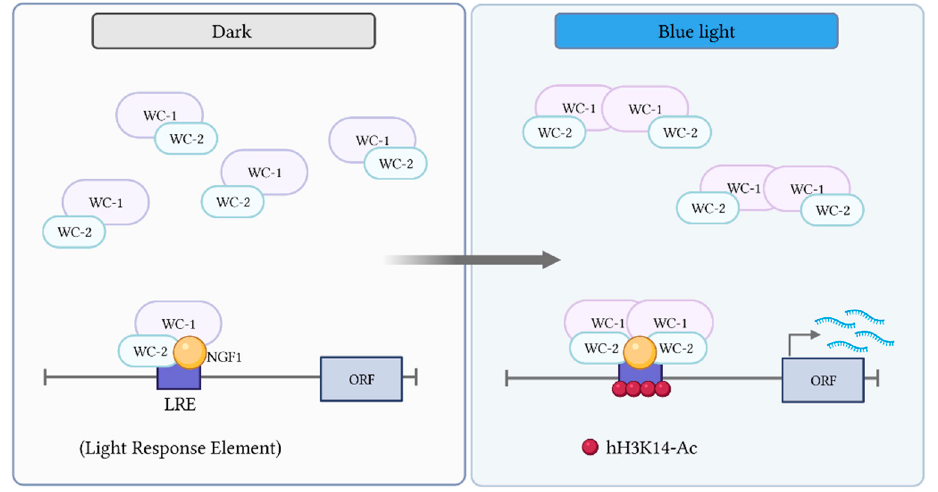
Figure 10. A simplified model for the activation of transcription by light and photoadaptation in N. crassa . In the dark, WC-1 and WC-2 are dimers. Light reception by the WC-1/WC-1 dimer should trigger the formation of a WCC-heterodimer, which in turn leads to chromatin remodeling through the histone acetyltransferase NGF-1 at the light response element, and the activation of gene transcription. The acetylated histones hH3K14-Ac are shown by red balls at the site of promoter binding.